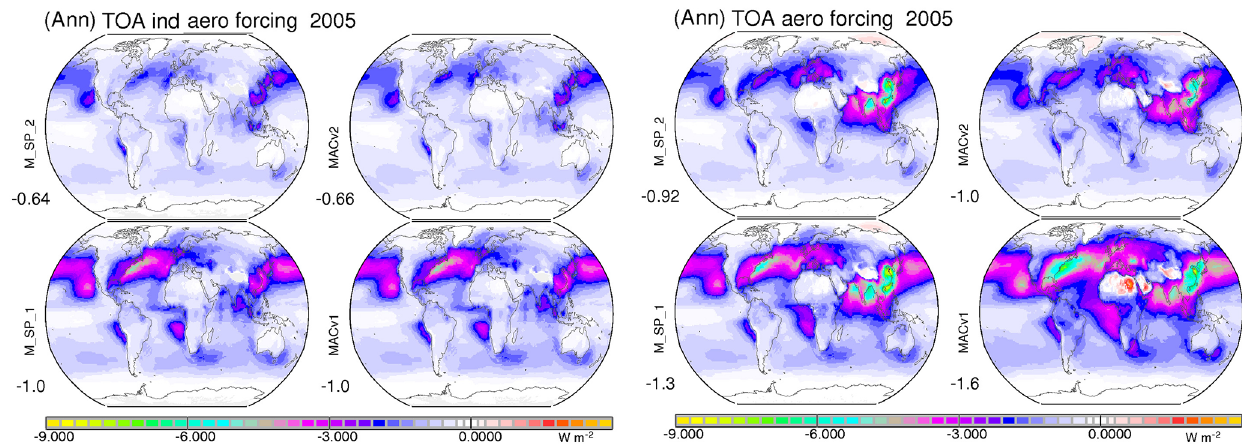
Figure B2. Annual maps for present-day aerosol indirect radiative forcing in watts per square meter (Wm − 2 ) at the TOA at (left frame) and for the combined direct and indirect radiative forcing (right frame) for MACv2-SP with MACv1 natural background (upper left) and with MACv2 natural background (lower left), for MACv2 (upper right) and MACv1 (lower right). Values below the labels indicate global